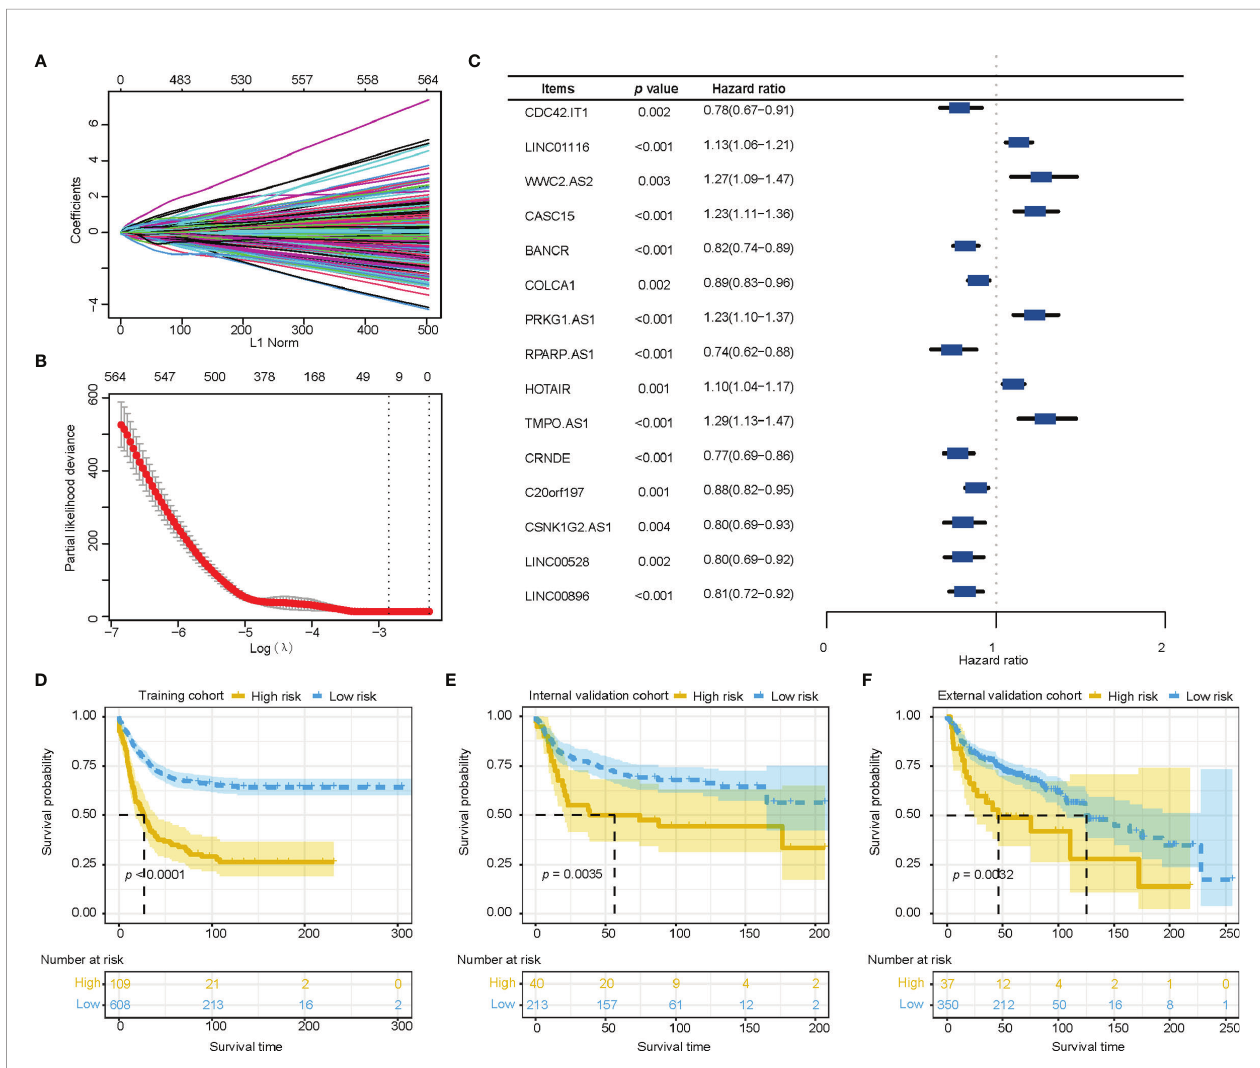
FIGURE 1 | Construction and veri fi cation of the immune-related lncRNA prognostic model. (A, B) The least absolute shrinkage and selection operator was utilized to construct an immune-related lncRNA model. (C) The forest plot of fi fteen immune-related lncRNAs was fi gured by multivariate cox regression analysis. (D – F) Survival analysis showed better survival among low-risk patients in training cohort, internal validation cohort, and external validation cohort. lncRNA, long non-coding RNA.